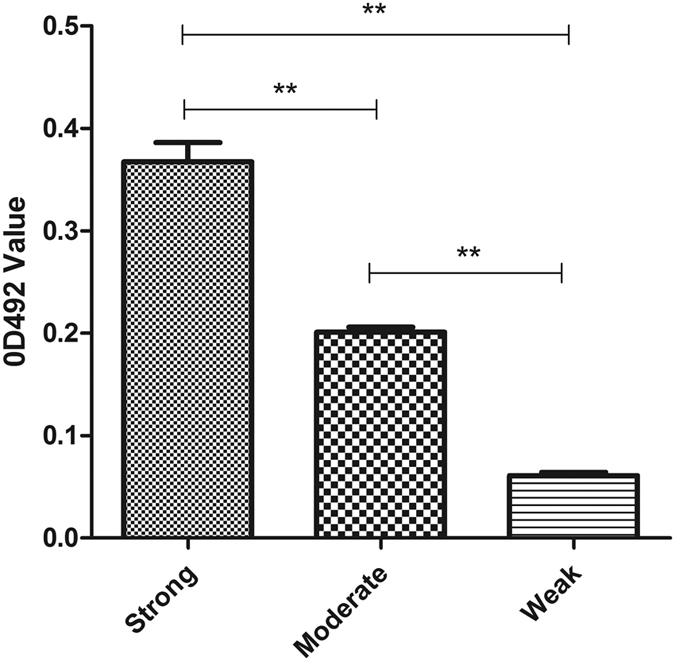
OD values of 45 S. maltophilia strains, indicating their capacity to form biofilms.Results are means ± SDs. **P < 0.01.